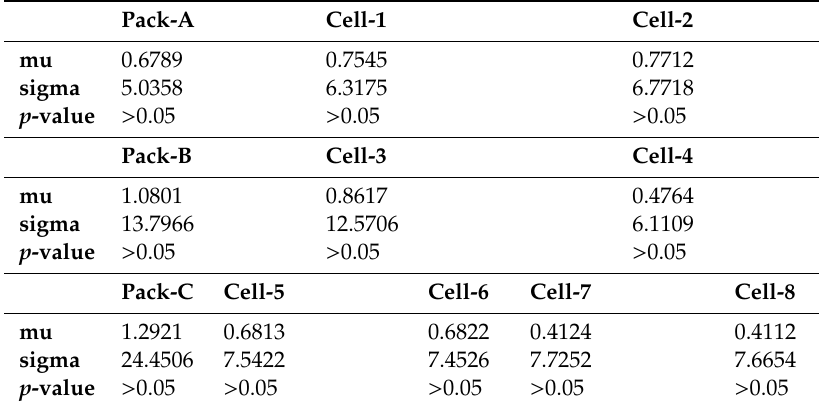
Table 6. Normality test results.